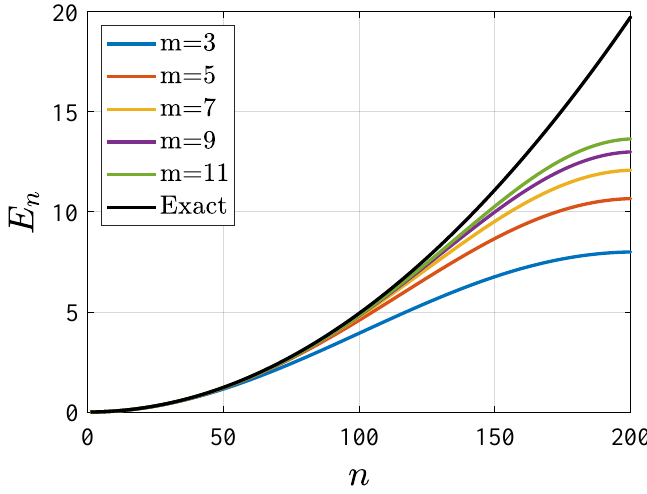
Figure A1. Eigenvalues of the kinetic energy operator E n , n = 1,2, . . ., as a function of the quantum number n as obtained by the standard FDM. The different plots correspond to different values of grid points employed to calculate the second order derivative, m (Equation (A1)), while keeping the total number of grid points and the box size constant. As m increases the accuracy of the second order derivative is increased. The chosen parameters are: ¯ h = 1, µ = 1, N = 201 and L = 100. Note that this figure is given for illustration reasons and is not novel (see for example Figure 1 in Ref.